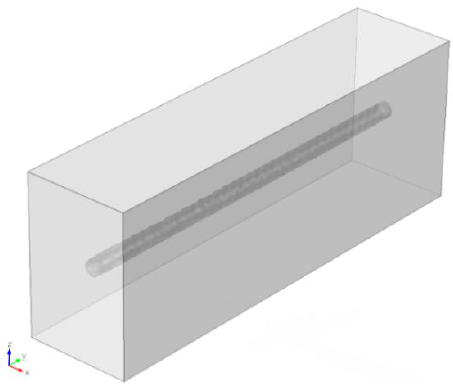
Figure 2. Solid rebar located in a box.